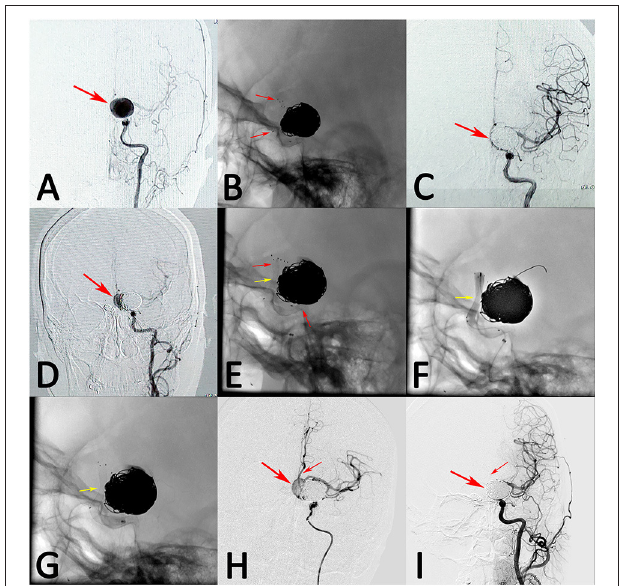
FIGURE 1 | A patient with left giant posterior communicating artery aneurysm was treated with stent-assisted coil embolization ( A , arrow). The stent deployed successfully and the aneurysm was occluded completely after treatment ( B,C , arrows). However, the aneurysm recanalized at 3 months follow-up ( D , arrow). The recanalized aneurysm was retreated with single pipeline embolization device, while the device was inadequately expanded ( E , middle arrow). Balloon angioplasty were performed, while the device was still expanded inadequately ( F , G , arrow). However, the blood flow of aneurysm was stasis and the distal blood flow was sufficient after treatment ( H , arrows). At 12 months follow-up, angiograph result showed that the aneurysm had complete occlusion, while the anterior cerebral artery was obliteration ( I , arrows).